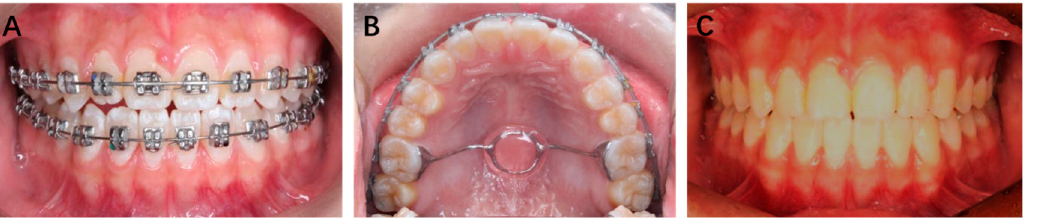
Figure 5. ( A ) Mild open bite in the anterior teeth; ( B ) a 3D TPA bonded on maxillary first molars; ( C ) corrected open